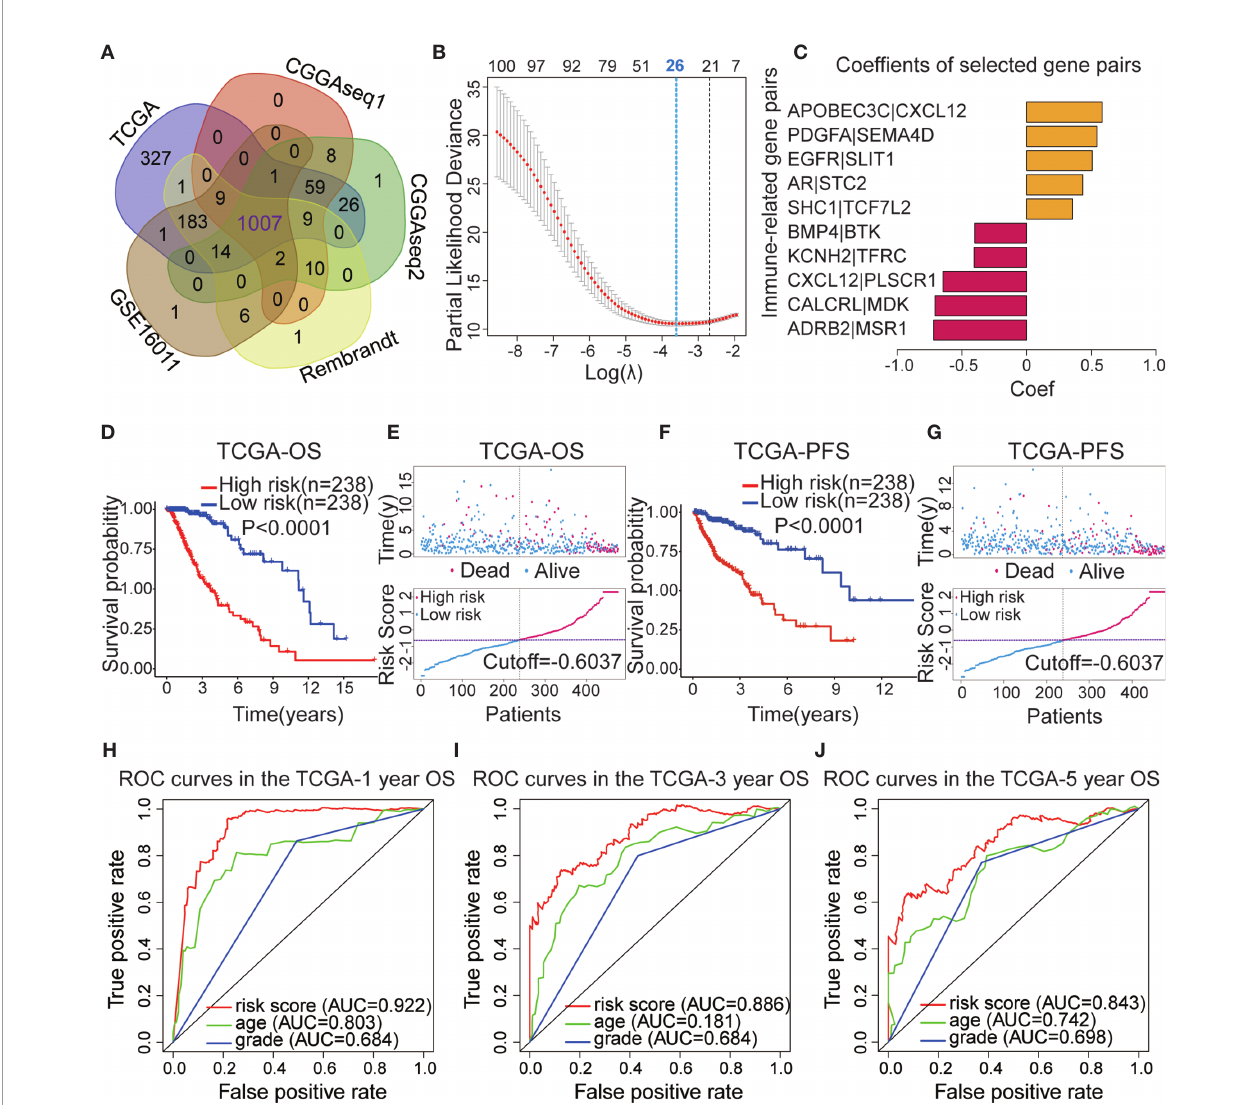
FIGURE 2 | (A) Venn diagram showing the 1,007 immune-related genes (IRGs) screened in all fi ve datasets. (B) Least absolute shrinkage and selection operator (Lasso) regression were performed to calculate the minimum criteria. (C) Multivariate Cox analysis was used to calculate the coef fi cients of the IRG pairs (IRGPs). (D) Kaplan – Meier (KM) survival curves revealed that the low-risk subgroup had better overall survival (OS) than the high-risk subgroup in The Cancer Genome Atlas (TCGA) dataset. (E) Survival status and distributions of risk scores (based on the IRGP signature) of primary low-grade glioma (LGG) patients in TCGA dataset. (F) KM curves showed that the high-risk subgroup had a worse platinum-free interval (PFI) than the low-risk subgroup in the TCGA dataset. (G) Survival status and risk score distribution scatter plots for primary LGG patients in TCGA dataset. (H – J) Receiver operating characteristic (ROC) curves for the IRGP signature for the prediction of 1/3/5-year survival in the TGGA